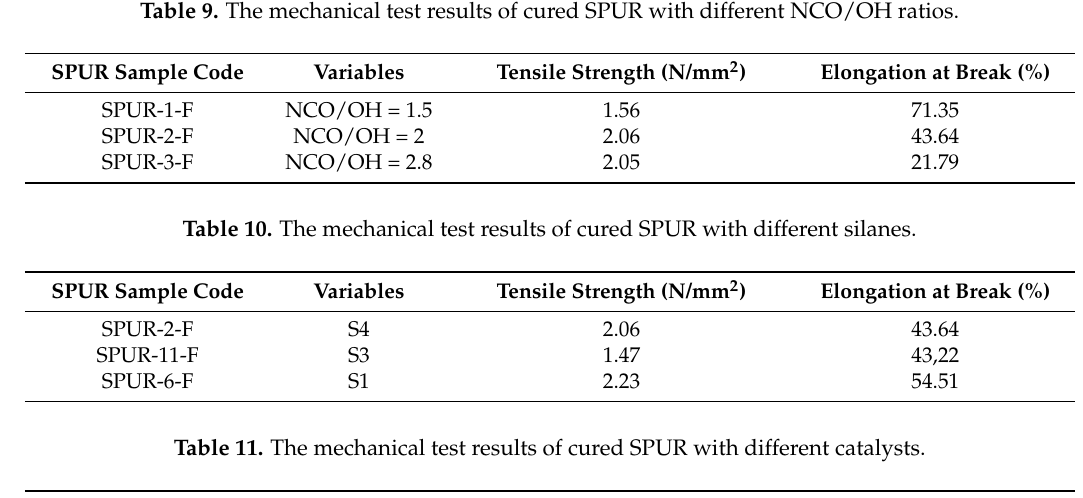
Table 9. The mechanical test results of cured SPUR with different NCO/OH ratios.